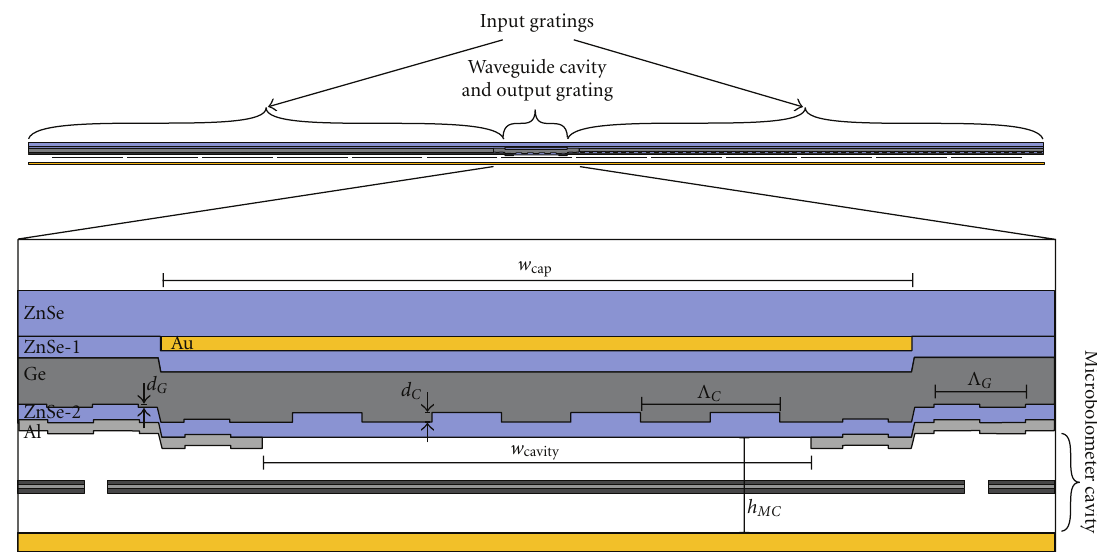
Figure 1: Schematic of wavelength filter and microbolometer array. The upper view shows the entire structure to the extent of the input gratings. The inset, shows the waveguide cavity, microbolometer cavity, and the first few periods of the input grating. The first two periods of the input gratings can be seen on the left and right edges of the inset and the four periods of the output grating can be seen in the center of the